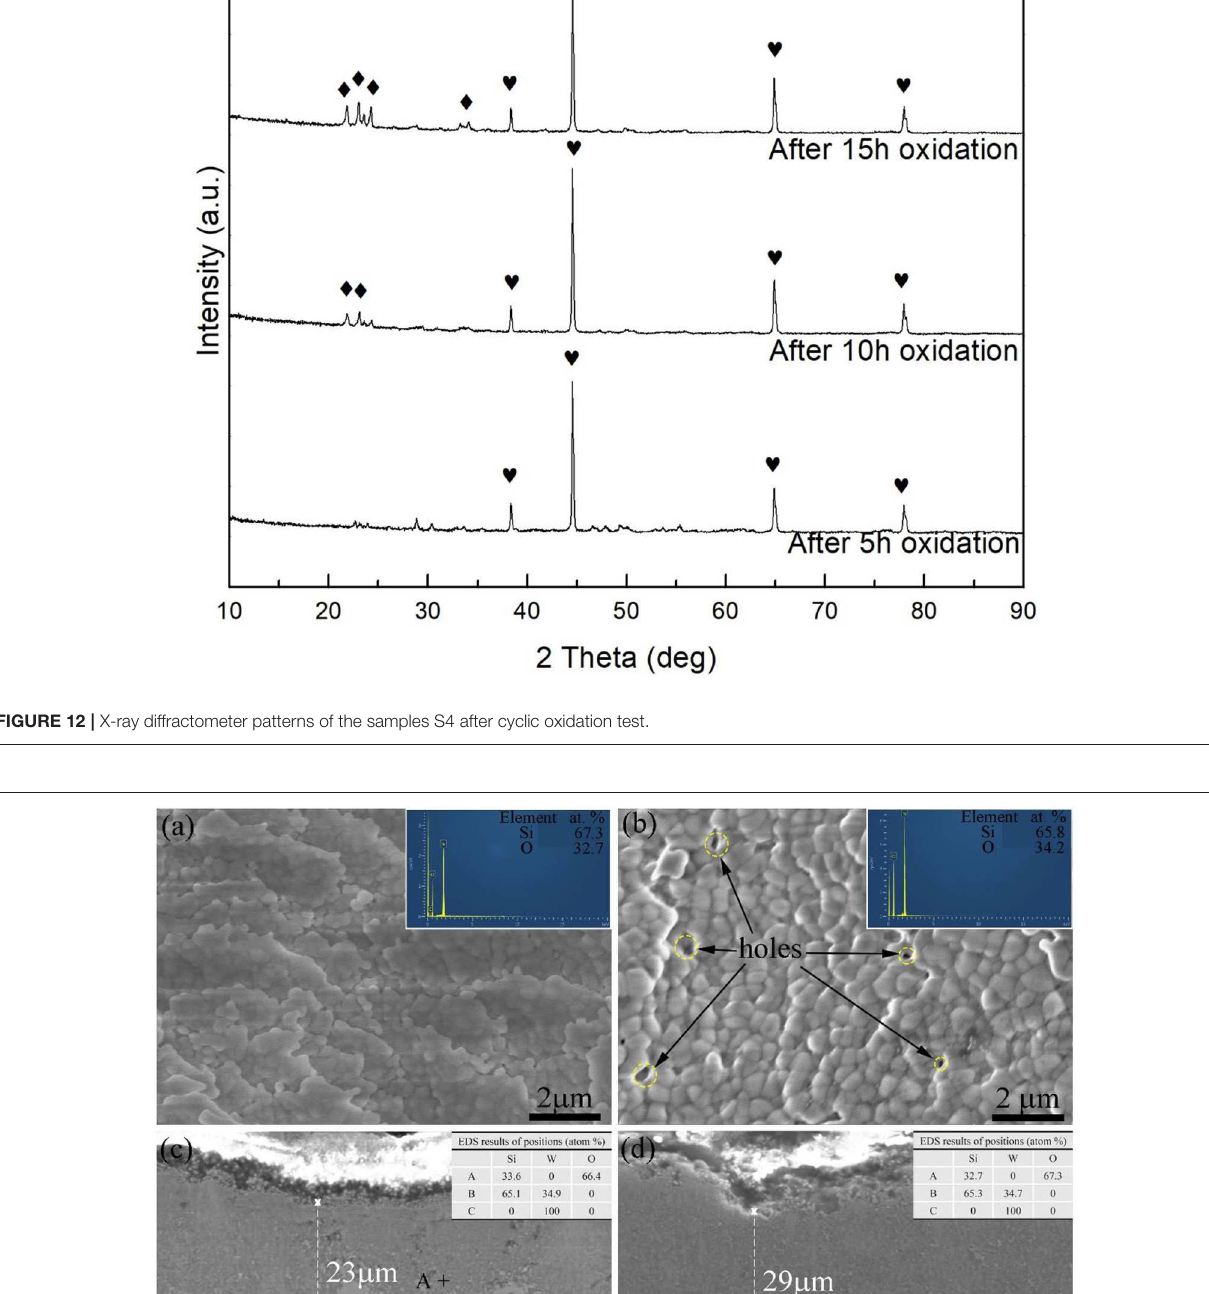
Frontiers in Materials | www.frontiersin.org